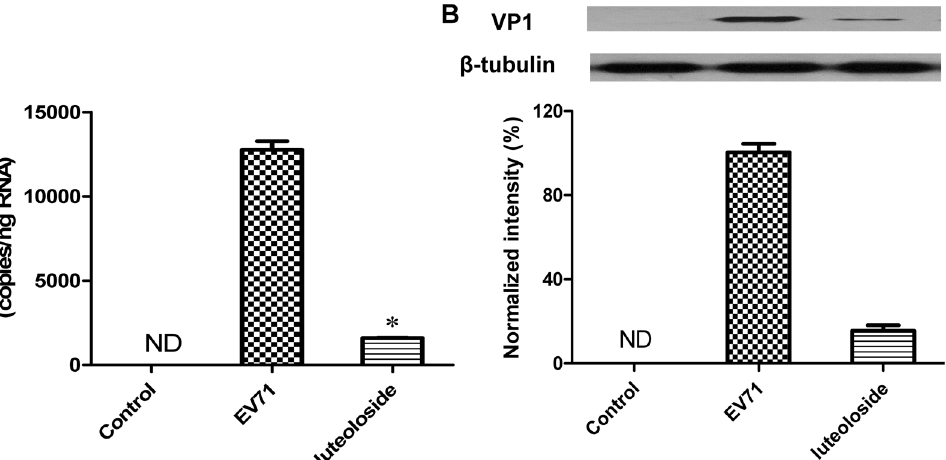
Fig 5. Luteoloside inhibited the production of viral proteins and nuclear acids. RD cells grown in 6-well-plate were infected with EV71 (MOI = 0.3) in the presence or absence of 0.5 mM luteoloside. Cells were lysed for total RNA and protein extraction at 12 hpi, respectively. (A) The RNA load was determined using the real-time PCR kit specific to VP1 gene. Data shown are the means ± SE from 6 independent measurements ( n = 6). Asterisk meant the data differed from the EV71 group significantly at P < 0.05 level according to t -test. (B) Protein samples, unified to 30 μ g, were subjected to 12.5% SDS-PAGE and then transferred to PVDF membrane to detect the level of EV71 VP1 protein. The amount of β -tubulin was used as internal standard. VP1 band intensity was analyzed and normalized to corresponding band intensity of β -tubulin. The band intensity of EV71 group was set as 100%. Data shown are the means ± SE from 3 independent measurements ( n = 3).